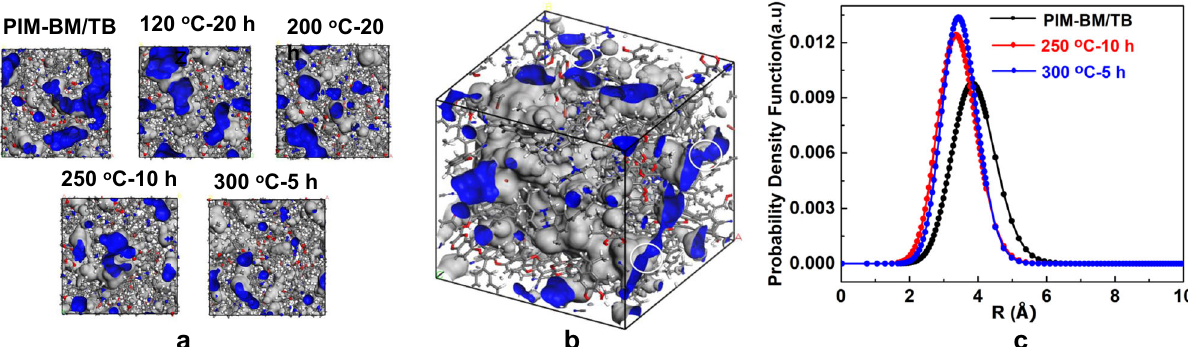
Fig. 5 Characterization of PIM-BM/TB and XPIM-BM/TB membranes physical structures. a Representative chain conformations in crosslinked PIM- BM/TB from computer modeling results. b 3-D view of crosslinked PIM-BM/TB modeling structure in an amorphous cell (300 °C-5 h) (cell size: 30 × 30 × 30 A; density: ~1.223 g/cm 3 ; Gray – Van der Waals surface; dark gray – Connolly surface with pore radius of 1.45 A). c Pore size distribution from PALS. Table 1 Gas permeabilities and selectivities of uncrosslinked PIM-BM/TB and crosslinked XPIM-BM/TB.